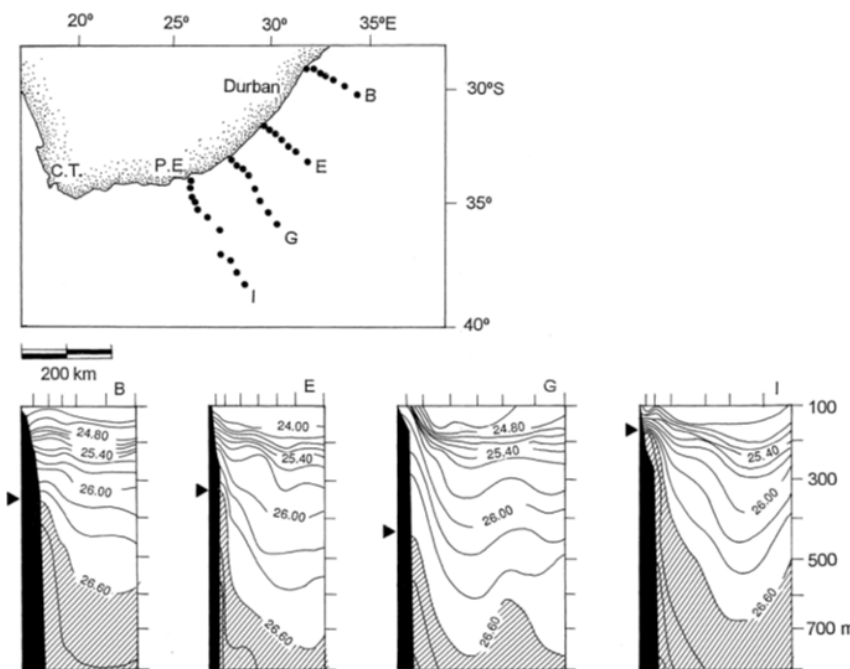
Figure 3. Sections across the Agulhas Current, showing sigma-t values obtained during March 1969 (after Harris and Van Foreest, 1978). All show water with a density greater than 26.60 upwelled along the inshore edge of the Agulhas Current. C.T and P.E represent Cape Town and Port Elizabeth,